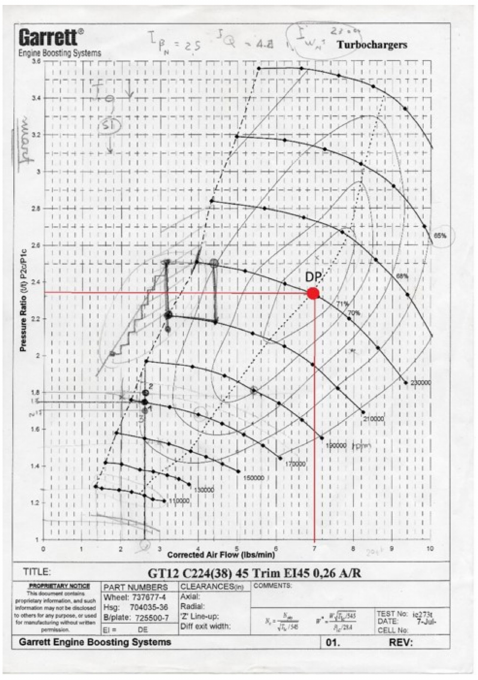
Figure 3. Garrett GT1238 compressor